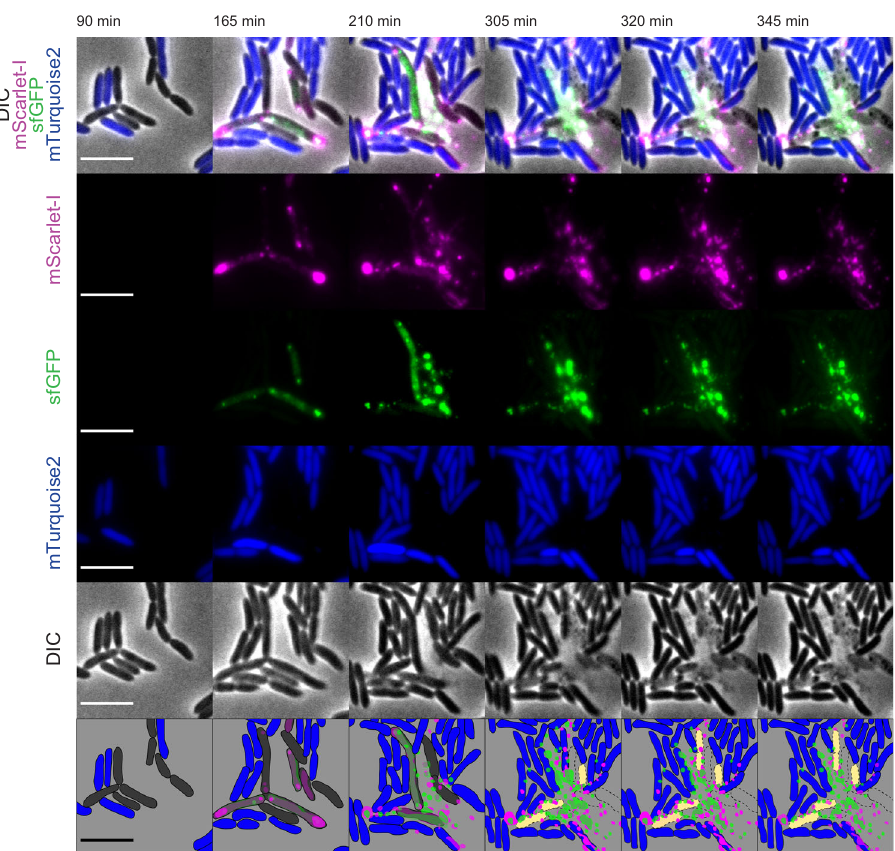
Fig. 5 Following induction of Pseudomonas protegens CHA0 R-tailocins are thrusted in the environment to kill competing Pseudomonas protegens Pf-5. CHA0 cells with tagged tailocin #1 (mScarlet-I) and tailocin #2 (sfGFP) were induced with mitomycin C, washed and confronted with Pf-5 mTurquoise2 cells and monitored with epi fl uorescence time-lapse microscopy (see Supplementary Movie 4). Cartoons outline the interaction at the different time points. CHA0 and Pf-5 mTurquoise2 live cells are shown in gray and blue, respectively. Ghost cells are outlined with a dotted line and are either not colored (CHA0) or fi lled with yellow (Pf-5). Tailocins #1 and #2 are depicted in magenta and green, respectively. The scale bar represents 5 µ